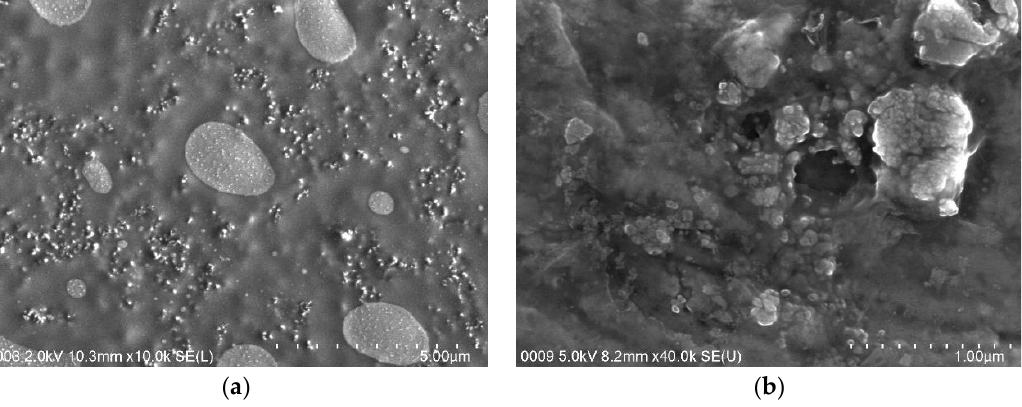
Figure 11. Morphology of ( a ) RNL as the control and ( b ) RNL@DES-5 at 10k and 40k magnification, respectively. Conditions: concentration of lipase: 1 mg mL −1 , 300 rpm, 2 h, pH 7.0, 40 °C, and 2 h. respectively. Conditions: concentration of lipase: 1 mg mL − 1 , 300 rpm, 2 h, pH 7.0, 40 ◦ C, and 2